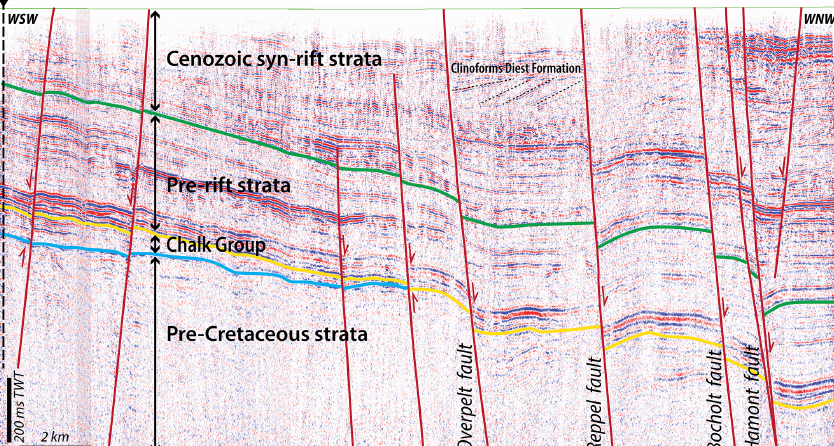
Figure 6. Composite seismic section across the northern structural domain of this study. The location of this section is shown in Fig. 5. Note the gradual decrease in thickness of the Chalk Group and increase in thickness of the Cenozoic syn-rift strata from west to east along the western part of this section. In the eastern part of this section, the Chalk Group is absent and Cenozoic syn-rift strata thicken stepwise across faults. The seismic expressions of some of the westward-prograding clinoforms in the Upper Miocene Diest Formation are indicated. In the westernmost part of this section, the deep borehole Lommel (DOV code: kb17d47w-B262 ) is indicated.